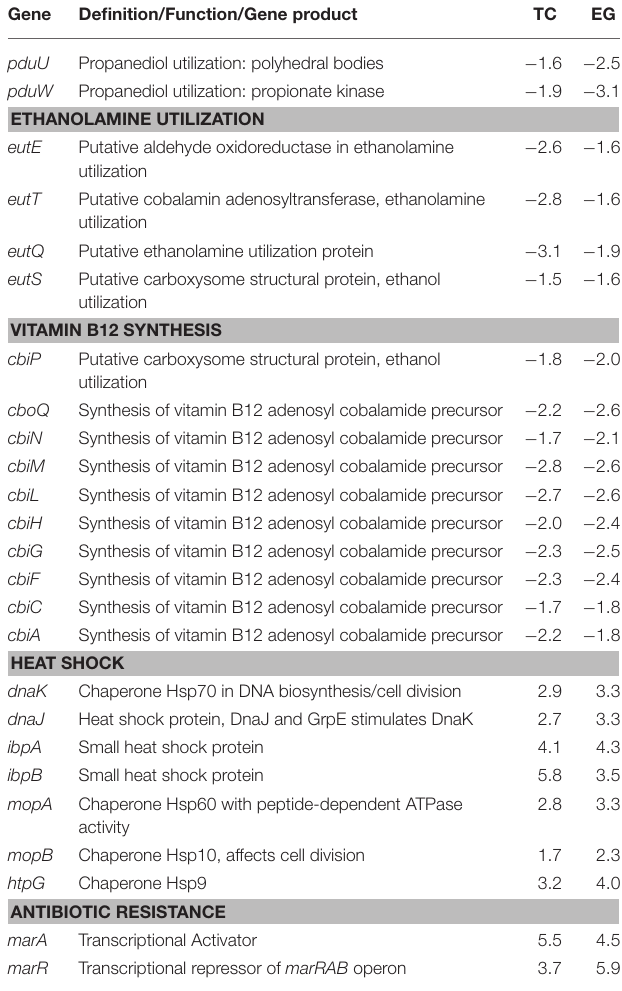
TABLE 1 | Major genes predicted to be differentially regulated in PT8 exposed to SICs of both TC and EG ( P < 0.005, M ± 1.5), based on the microarray